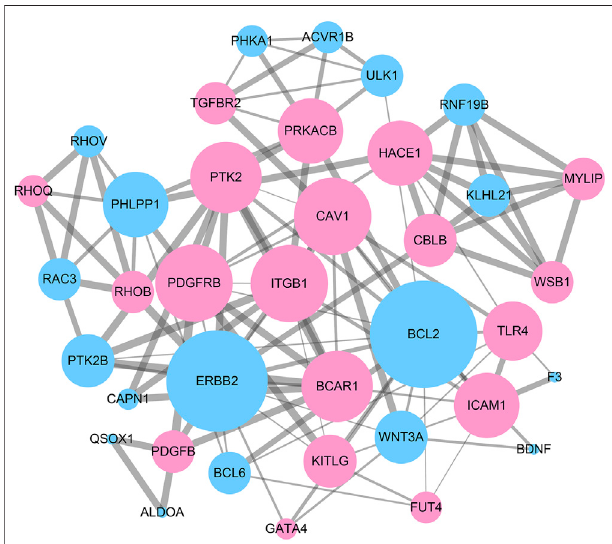
FIGURE6| Asub-networkmodulewiththehighestscoreinPPInetwork consisting of 37 nodes and 113 edges. Red nodes represent up-regulated DEGs and blue nodes represent down-regulated DEGs. Nodes with higher degree are performed with larger size. Edges with higher combined_score are depicted with thicker lines.